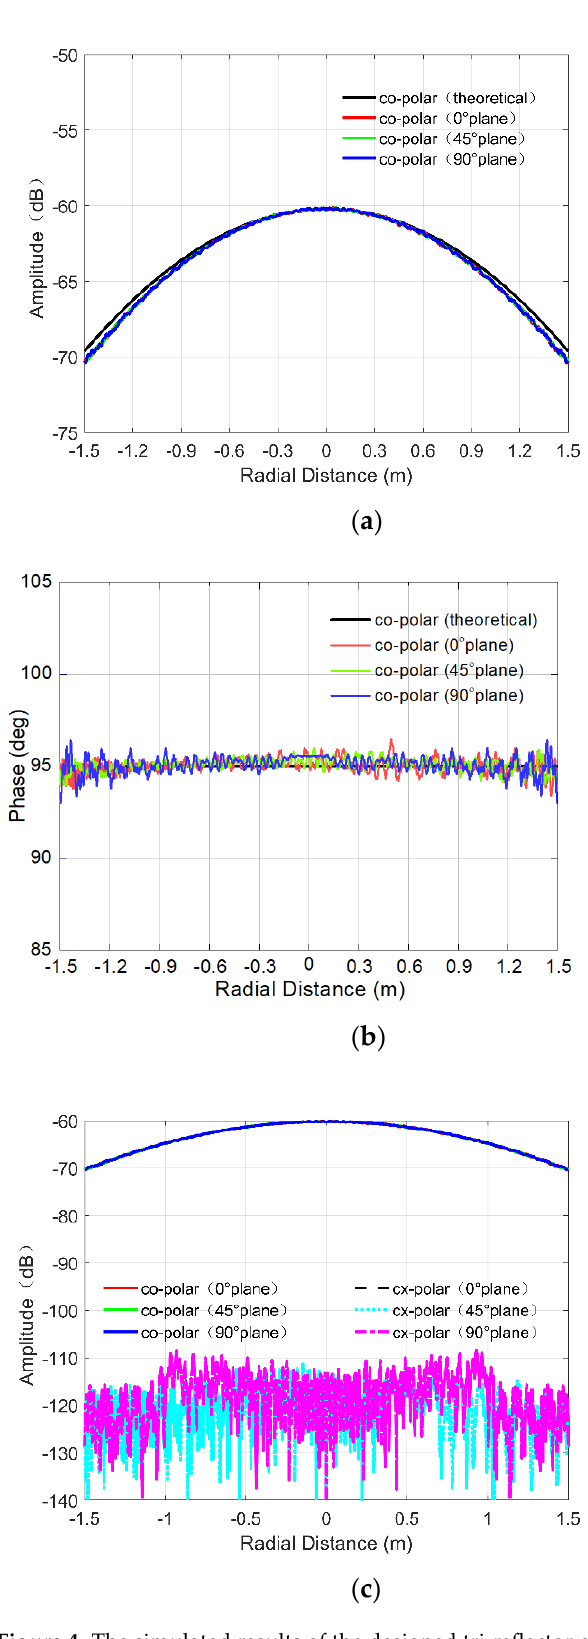
Figure 4. The simulated results of the designed tri-reflector compact antenna test range (CATR) with standard quadric surfaces when illuminated by an ideal Gaussian feed at 100 GHz. ( a ) Co-polar amplitude; ( b ) co-polar phase; ( c ) co- and cross-polar amplitude.